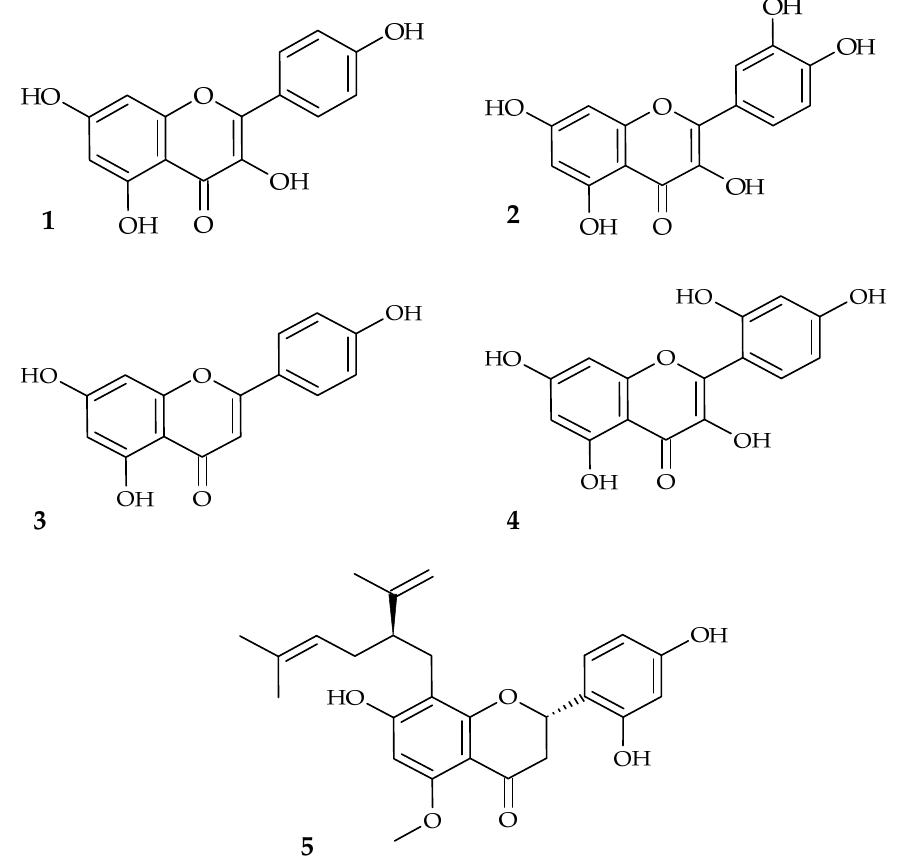
Figure 1. The chemical structures of selected flavonoids with antibacterial activity against agents of oral infections ( 1 . kaempferol, 2 . quercetin, 3 . apigenin, 4 . morin, 5 . kurarinone).